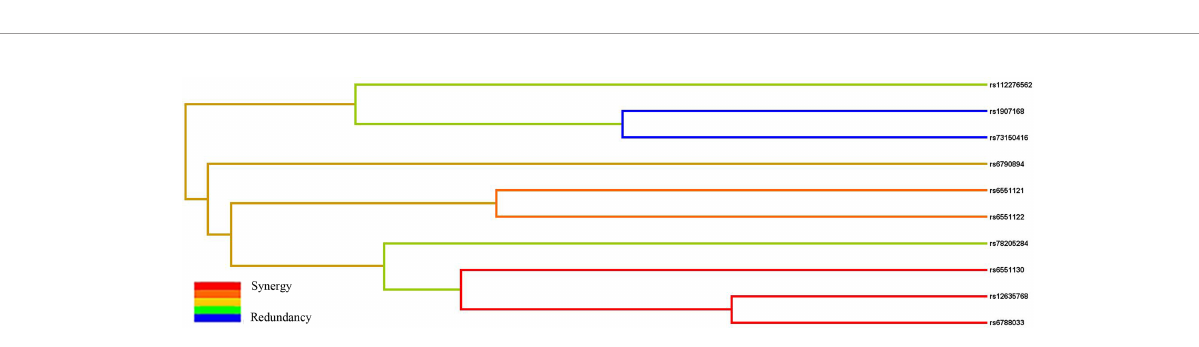
Frontiers in Oncology |